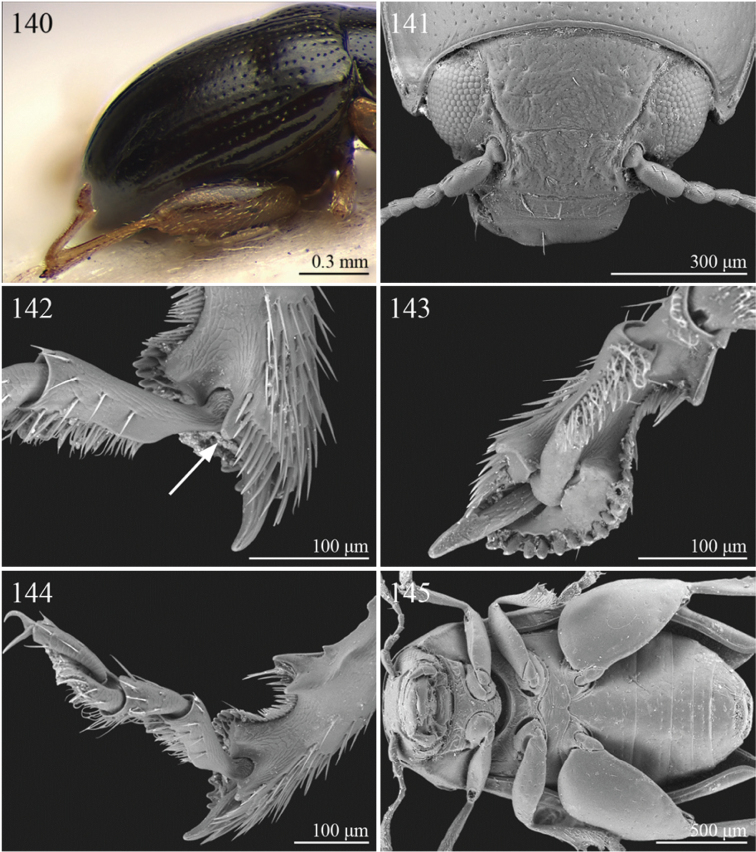
Morphological characters. 140
Bikasha fortipunctata Maulik, hind leg and elytra in lateral view 141
Biodontocnema brunnea Biondi, head in frontal view 142 Ditto, distal half of hind tibia and metatarsus 143 Ditto, hind tibial socket 144 Ditto, dentiform process (white arrow) in inner apical side of hind tibiae 145 Ditto, ventral parts.